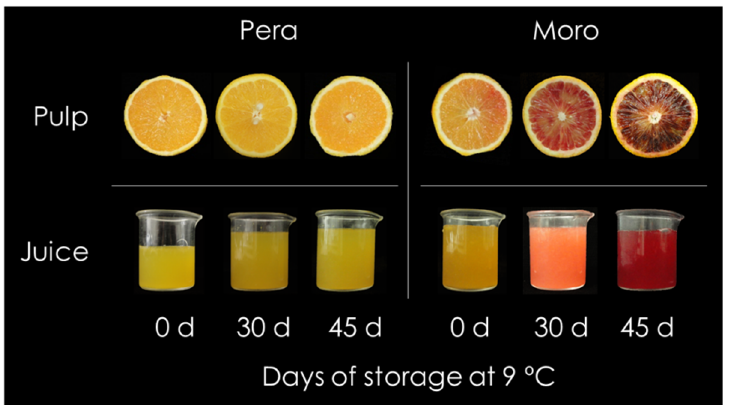
Figure 2. Internal oranges appearance and colour of pulp ( up ) and juices ( down ) of Pera ( left ) and Moro ( right ) oranges from Sao Paulo (Brazil), during storage at 9 °C for 0, 30 and 45 days. Table 1. Maturity index, pH, flavonoids and anthocyanin content of Pera and Moro pulp during storage for 0, 30 and 45 days. Statistical analyses were performed using ANOVA and different letters indicate statistically significant different values ( p ≤ 0.01) for a given